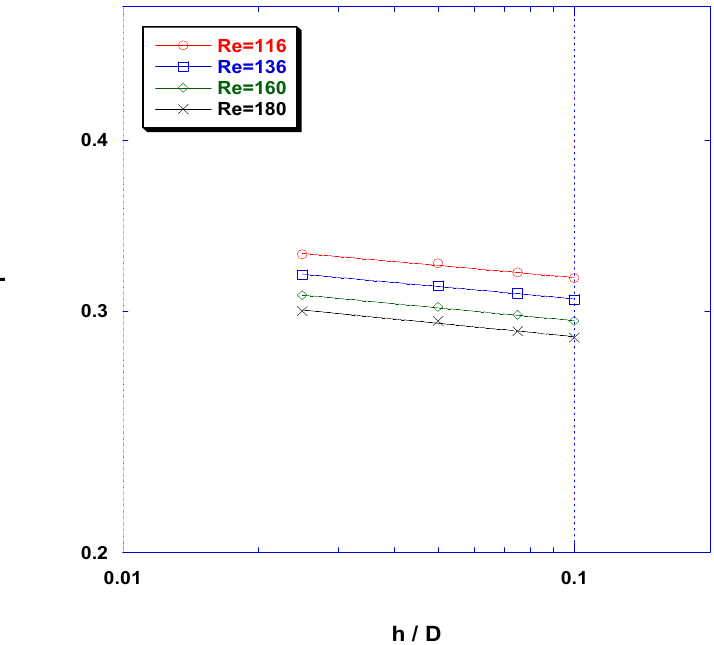
Figure A1. Dimensionless pressure drop (friction factor) as a function of the ratio h / D .